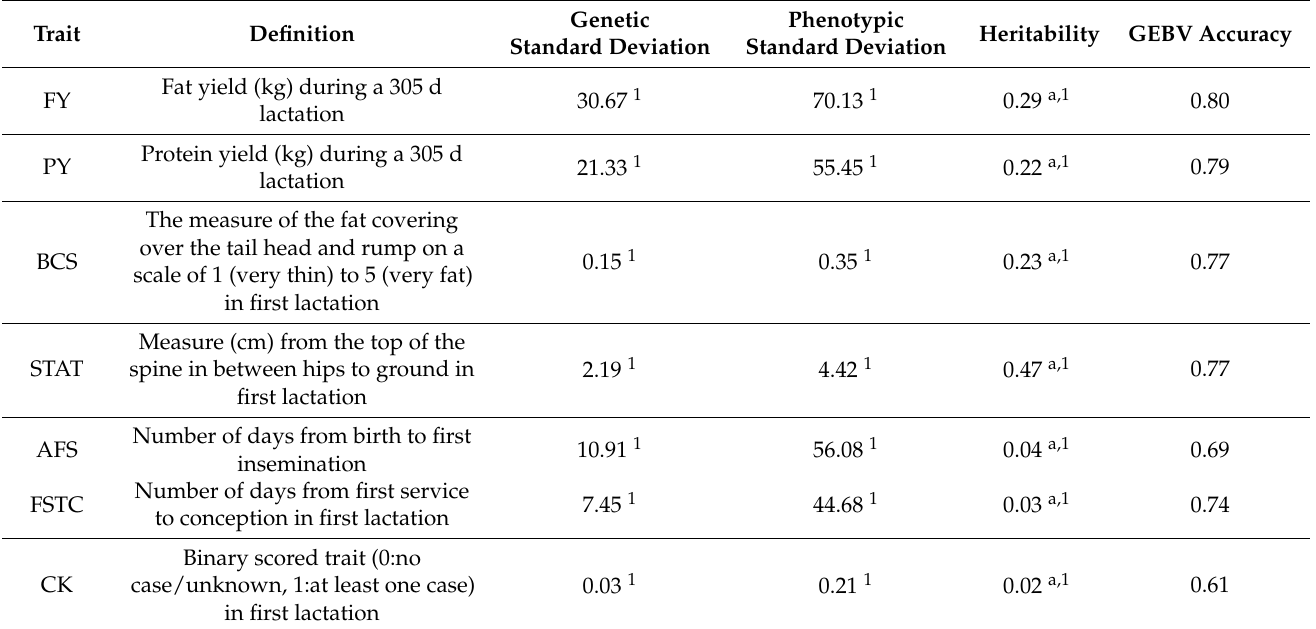
Table 1. Trait definitions, genetic and phenotypic standard deviations, heritability estimates, and genomic accuracy.